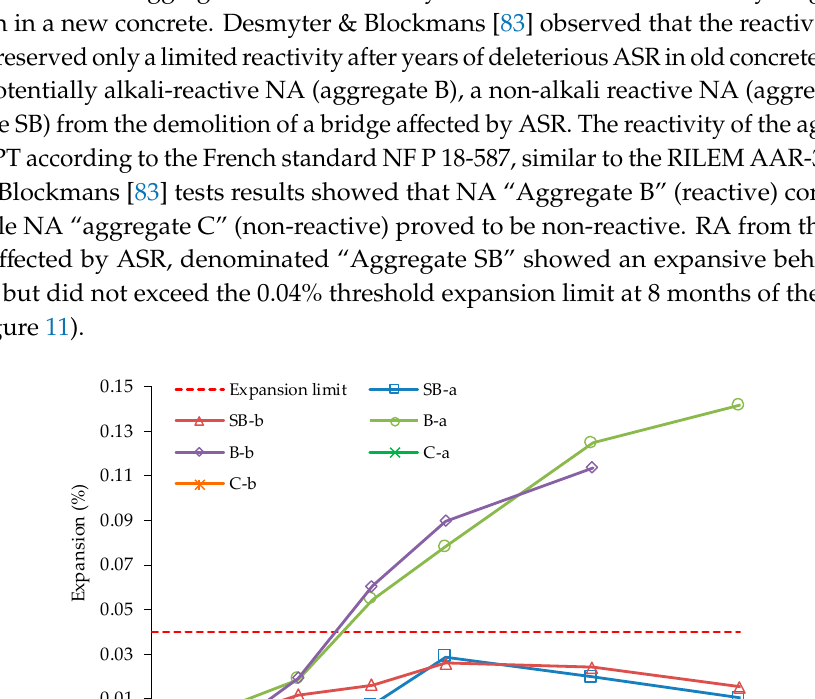
Figure 10. Evolution of the expansion in reactive concrete mixes using the RILEM AAR-3 method [82].